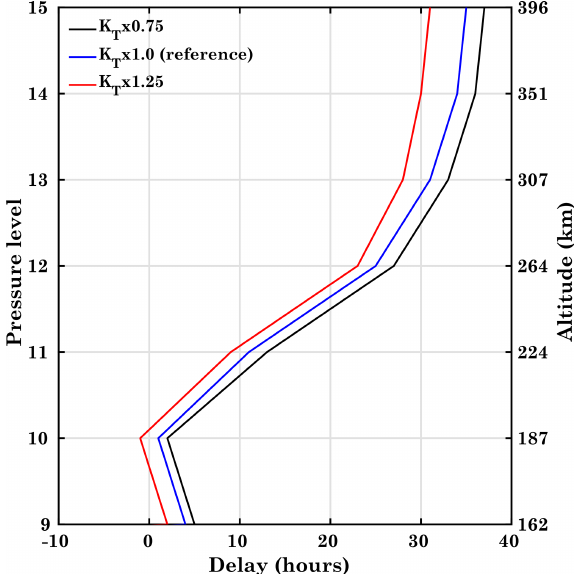
Figure 7. Vertical distribution of time delay between the atomic oxygen ion density and the F10.7 index for different transport con- ditions, K T × 0 . 75, K T × 1 . 0 (reference), and K T × 1 . 25, at geo- graphic coordinates 40 ◦ N, 18 ◦